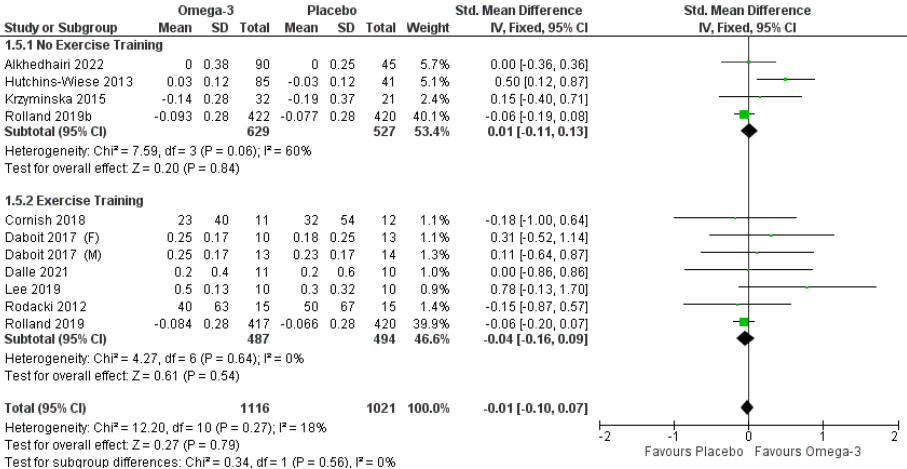
Figure 6. Pooled analysis of the impact of omega-3 supplementation on sit-to-stand performance.